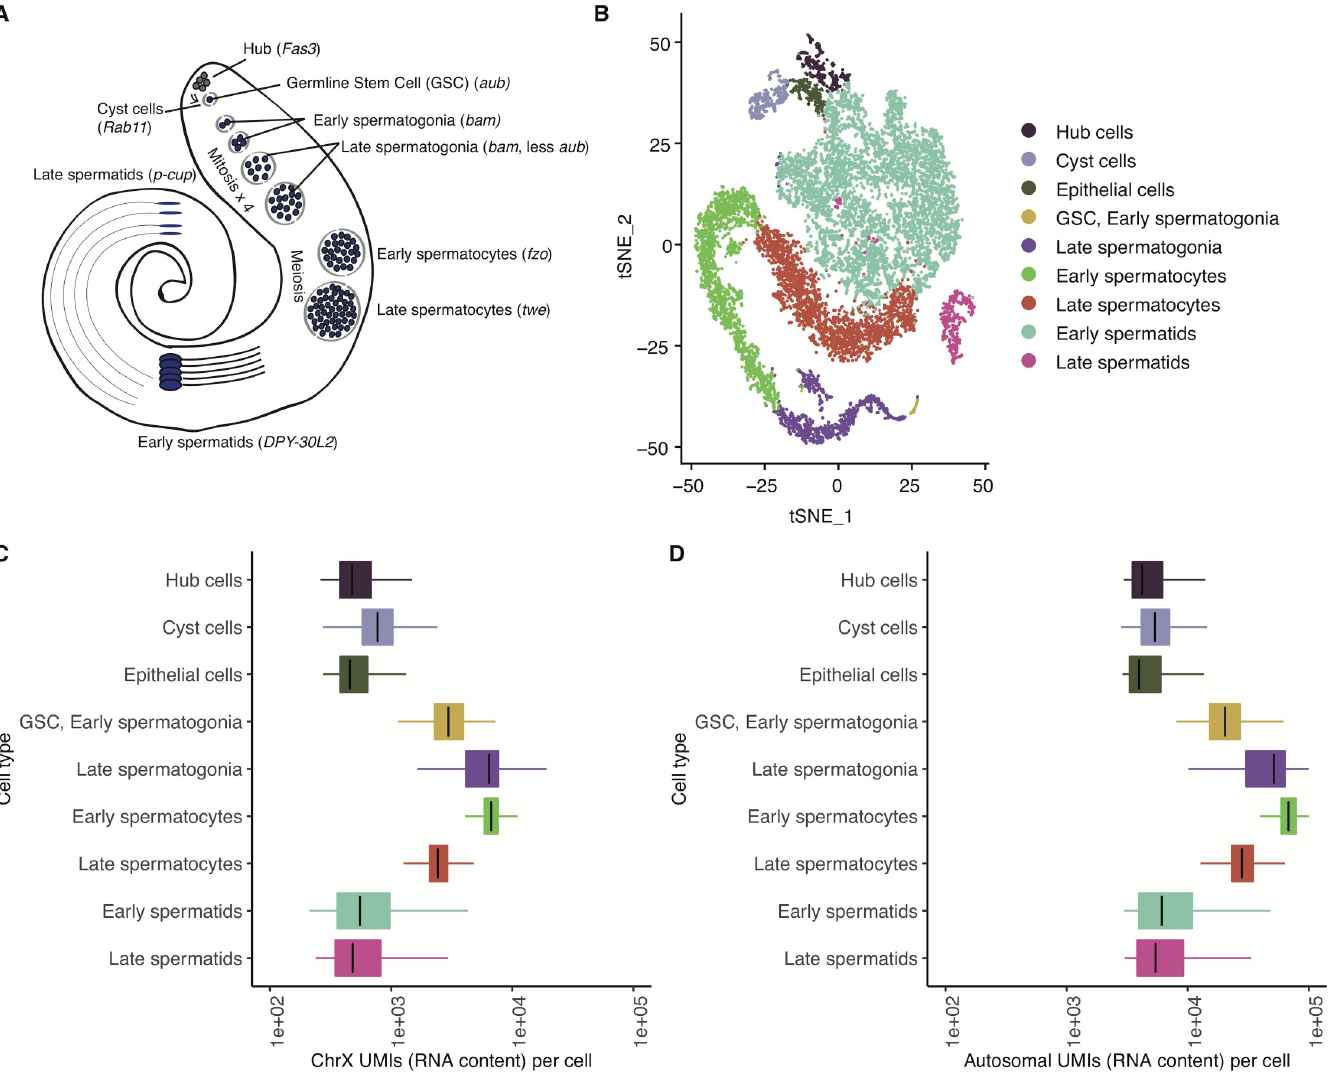
Fig 1. Integrated analysis of testis sequencing from two D. melanogaster strains. A) A schematic showing the types of cells present inside Drosophila testis. Germline stem cells differentiate into spermatogonia, which undergo mitosis and become spermatocytes, which undergo meiosis and become haploid spermatids. B) t-SNE plot showing a dimensional reduction of our combined, normalized libraries. Each point is a cell, clustered according to its similarity to other cells. C and D) For every cell, the number of RNA molecules detected from the X chromosome and autosomes approximated by the summed number of Unique Molecular Indices counted per cell. X and autosomes are both downregulated during late spermatogenesis. Count numbers and ratios are shown in S1